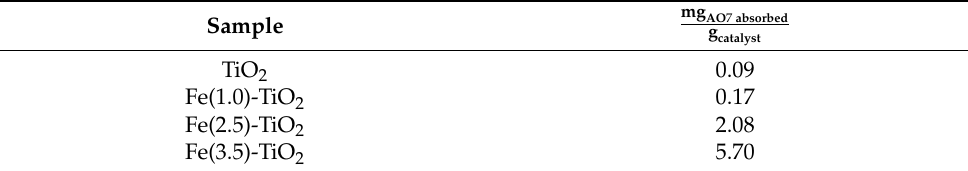
Table 3. AO7 adsorbed with respect to the load of photocatalyst.